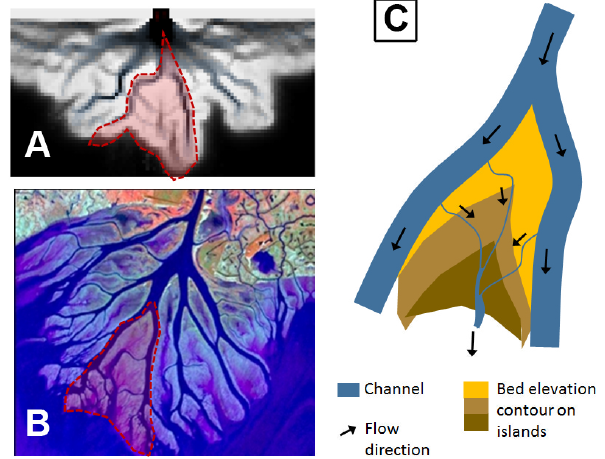
Figure 10. Flow features on the island of a delta formed in a shal- low basin. (a) Model result from run 6, where basin depth (2.5m) is only half of the inlet channel depth (5m); (b) Wax Lake Delta, where basin depth ( < 5m) is much lower than the inlet channel depth ( > 20m); (c) schematic drawing showing the “tributary” flow feature on the island (Shaw et al., 2013) observed both in the field (Shaw, 2013) and in our numerical model